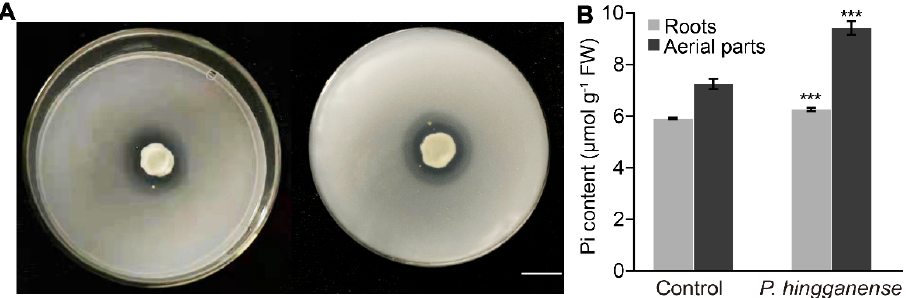
Figure 1. Enhanced inorganic phosphate (Pi) content in Parametarhizum hingganense -treated mung bean plants. ( A ) Clear zone of tricalcium phosphate solubilization on the National Botanical Research Institute’s phosphate growth medium (NBRIP) produced by P. hingganense (left, front view; right, bottom view). Bar, 1cm. ( B ) Pi content in P. hingganense -treated and non-treated mung bean plants. Values are means ± SD ( n = 3). Asterisks indicate significant differences as evaluated by Student’s t -tests: *** p < 0.001.